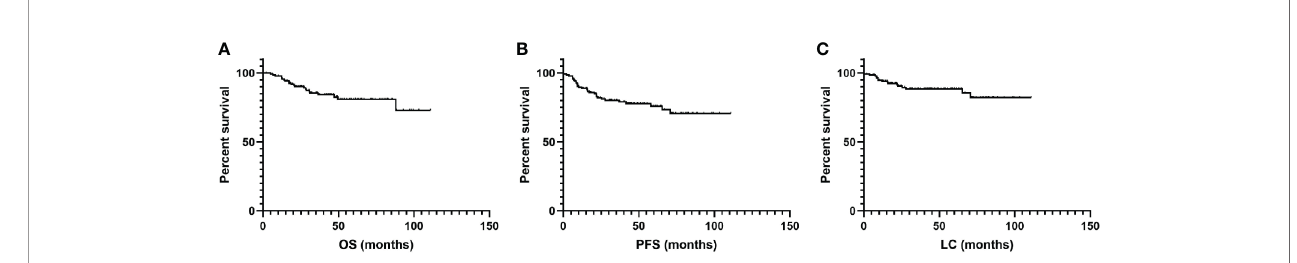
FIGURE 2 | Kaplan – Meier curves for (A) overall survival (OS), (B) progression-free survival (PFS), and (C) local control (LC) after salvage radiotherapy treatment